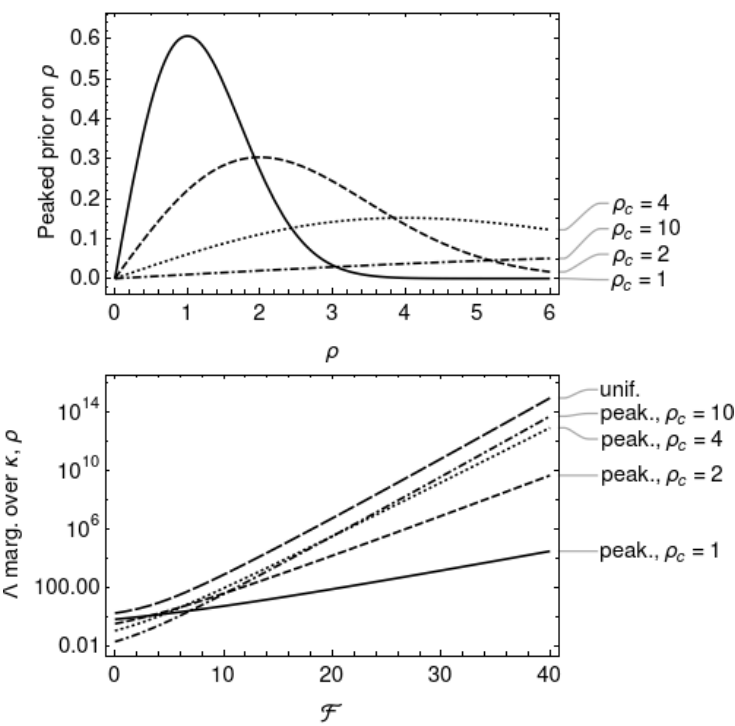
Figure 4. Top: the peaked prior on ρ (Equation (24)) as a function of ρ , for choices of the parameter ρ c . Bottom: the likelihood ratio marginalised over κ and ρ as a function of , with the peaked prior F on ρ (Equation (25)) for choices of ρ c , and with the uniform prior (Equation (21)). Figure 5 plots the likelihood ratios Λ exp. ( x ; , ρ 0 ) and Λ peak. ( x ; , ρ c ) marginalised F F over κ and ρ with the exponential and peaked priors, respectively, as functions of the priors’ = 2, the expectation respective parameters ρ 0 and ρ c . The likelihoods are evaluated at F = 2 value of assuming no signal is present. The behaviour of the likelihood ratios at F F gives some indication of which hypothesis is favoured in the absence of evidence for a signal. Both likelihood ratios favour the noise hypothesis ( Λ < 1) for strictly positive parameter values. The limiting behaviour at zero parameter values are: